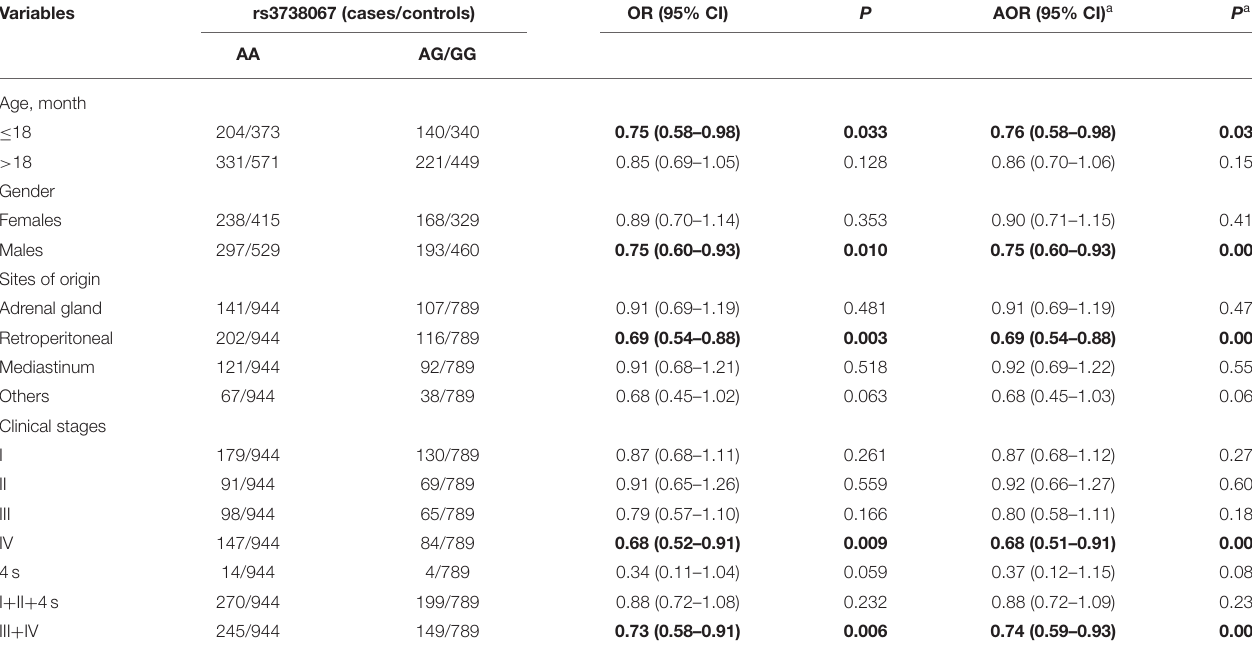
TABLE 2 | Stratify analysis for YTHDF2 rs3738067 A > G polymorphism and neuroblastoma susceptibility. Variables